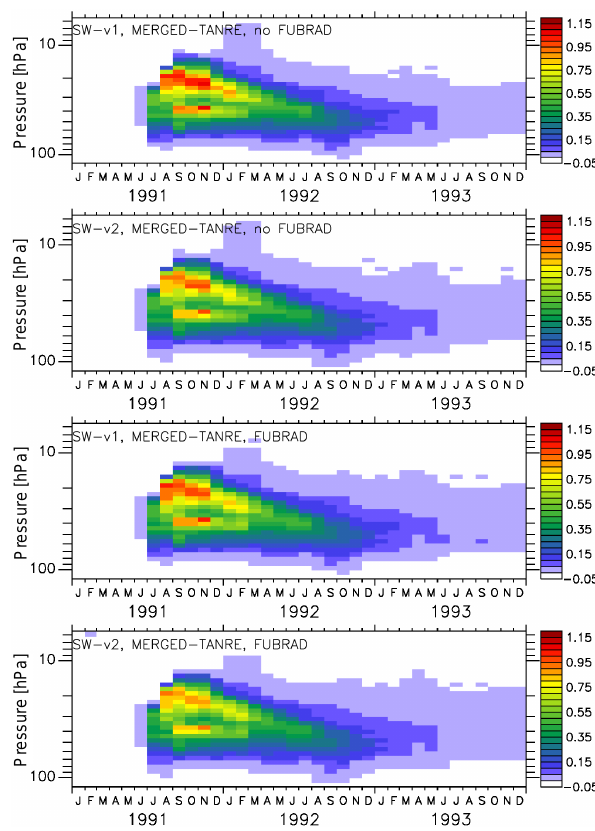
Figure 2. Simulated temporal evolution versus pressure altitude of the volcanic heating rates (in Kday − 1 ) in the tropics (5 ◦ S–5 ◦ N) due to the eruption of Mt.Pinatubo in June 1991. The different pan- els show the results for SW-v1 and SW-v2 of the shortwave scheme, both with and without FUBRAD (as